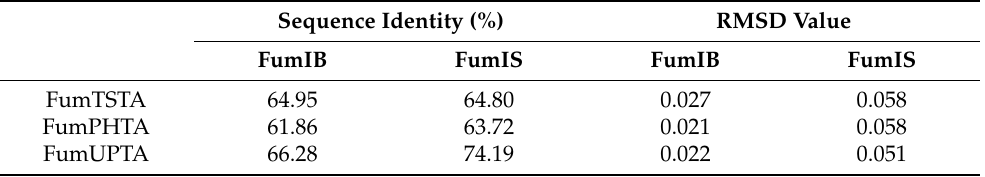
Table 1. Analysis of sequence identity and RMSD value of